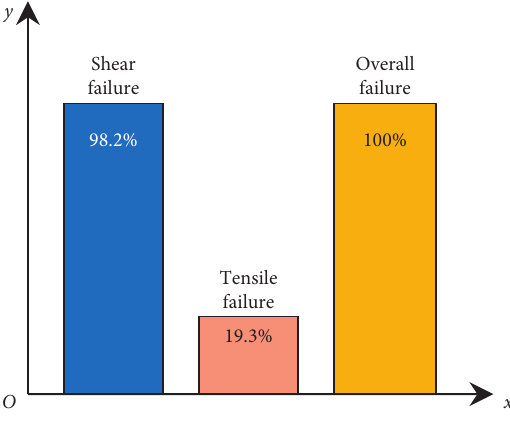
Figure 12: Crack model in the